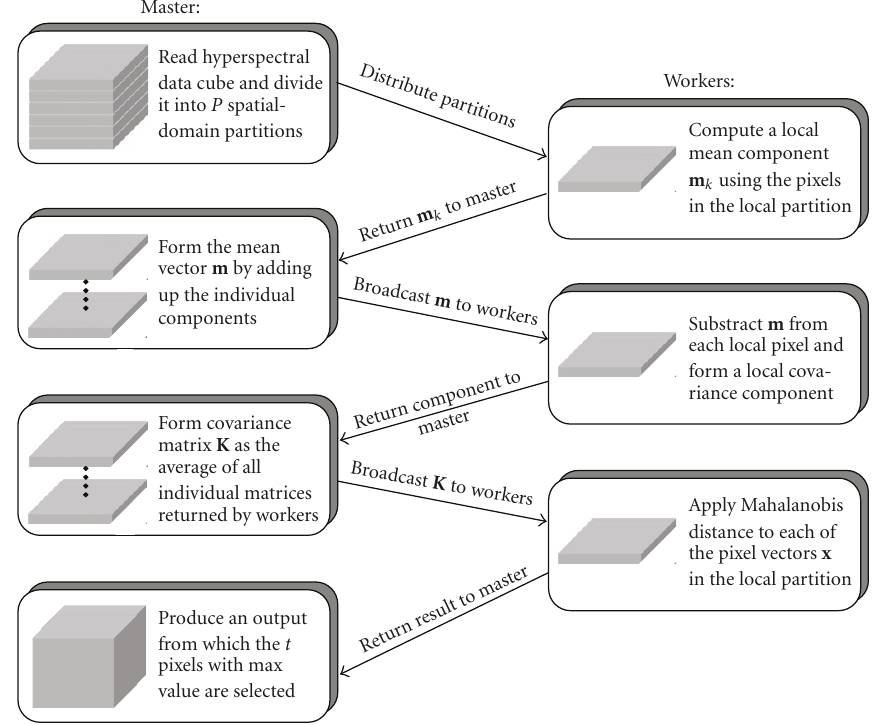
Figure 7: Parallel implementation of the RX algorithm in clusters of computers.